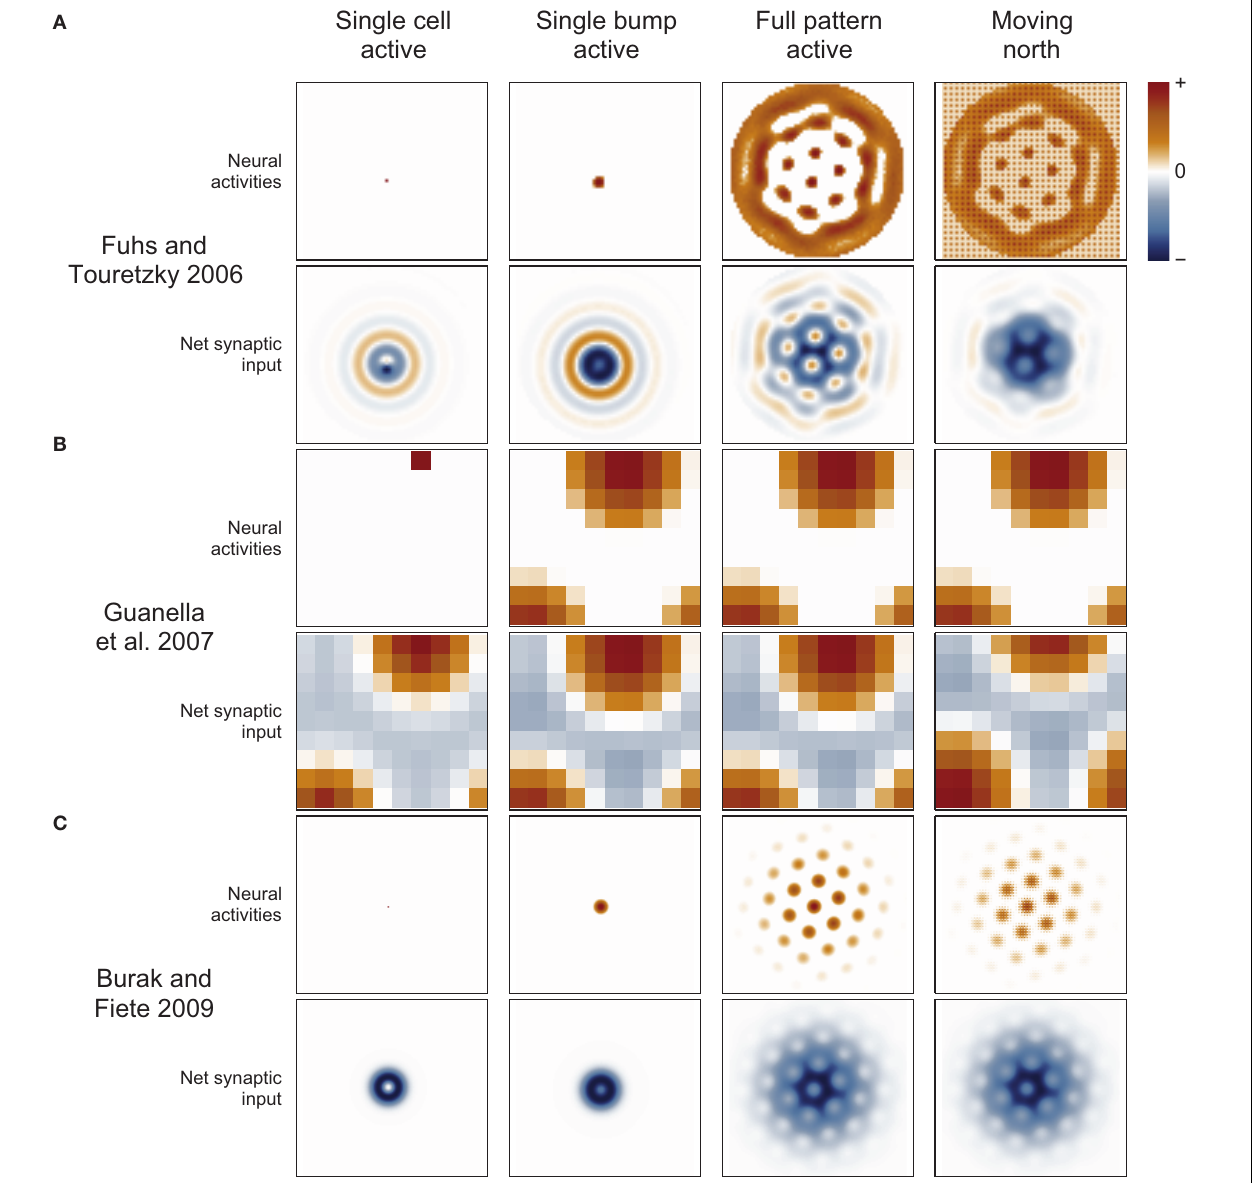
FIGURE 3 | Synaptic connections play a major role in continuous attractor networks. For each of three 2D attractor models, we plot the activity of the sheet of neurons (top in each row) and the synaptic input to each cell caused by that activity (bottom in each row). (A) Each cell in the Fuhs andTouretzky (2006) model projects symmetrically outward in alternating rings of excitatory and inhibitory synapses. Just offset from the center, in this case downward, is an asymmetric inhibitory region (dark blue).When this cell fires, it inhibits the nearby cells except in a small region just above it where other cells are free to fire. Cells have different offset directions, so a bump of activity can form in a small group of cells that each inhibit a different direction around the bump, surrounding it in a ring of inhibition. All the cells here are driven to fire, creating new bumps spontaneously, and the excitatory ring surrounded by inhibition on each side encourages the new bumps to maintain a particular spacing.When the animal moves north, north-conjunctive cells increase in activity (producing the checker boarding of activity), increasing the inhibition on